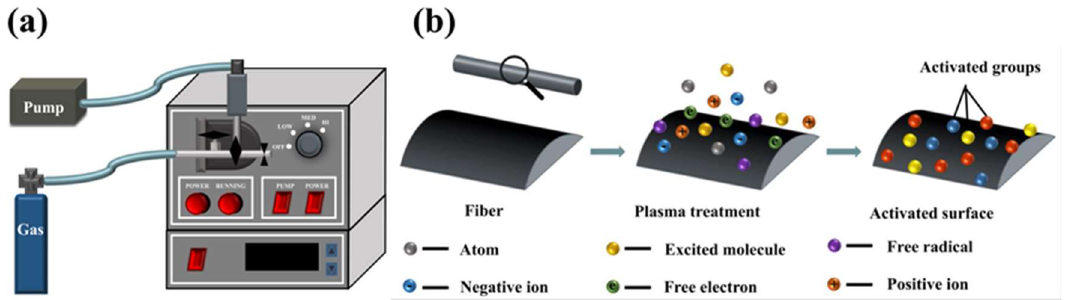
Figure 1. Diagram of the plasma treatment equipment: ( a ) plasma treatment equipment; ( b ) mechanism of surface plasma treatment.